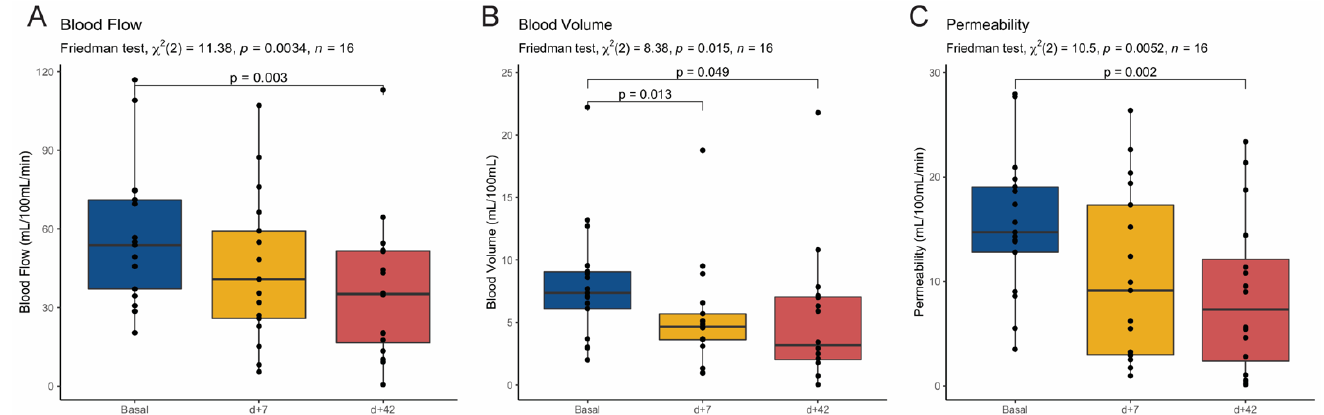
Figure 3. Boxplots showing values of blood flow ( A ), blood volume ( B ), and permeability ( C ) at baseline, day +7, and day +42 after treatment initiation in the entire population. Table 2. Perfusion parameters shown are mean values, with the standard deviation in parentheses.